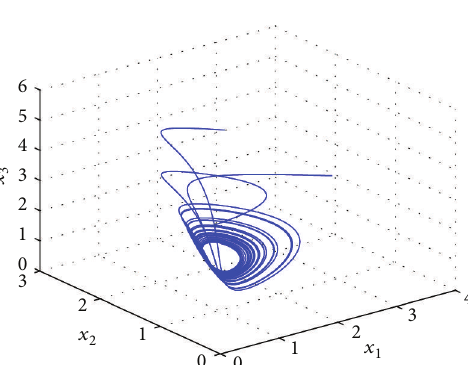
Figure 6: Rhythmic errors 𝑒 𝑖2 in BA